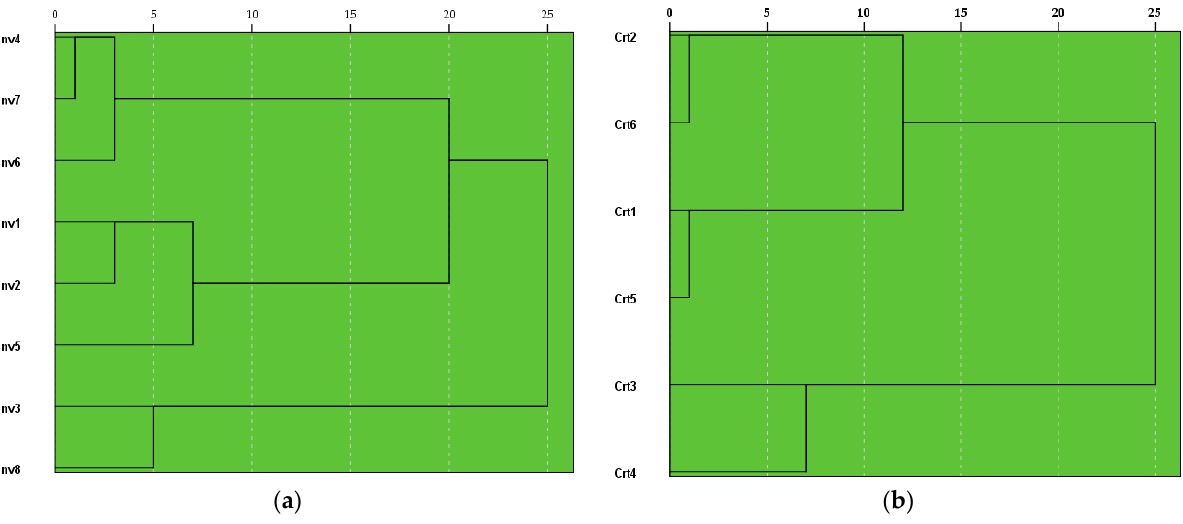
Figure 5. A dendrogram of clustering of relevant inventions ( a ) using fuzzy logic in combination with NIR grading, according to the selection criteria ( b ). The y-axis parameters on the left correspond to the Inv1–Inv8 invention numbers in Table A1, on the right to the Crt1–Crt6 selection criteria numbers from Table A1. The x-axis displays the Euclidean distance to the cluster center calculated using Ward ’ s method.